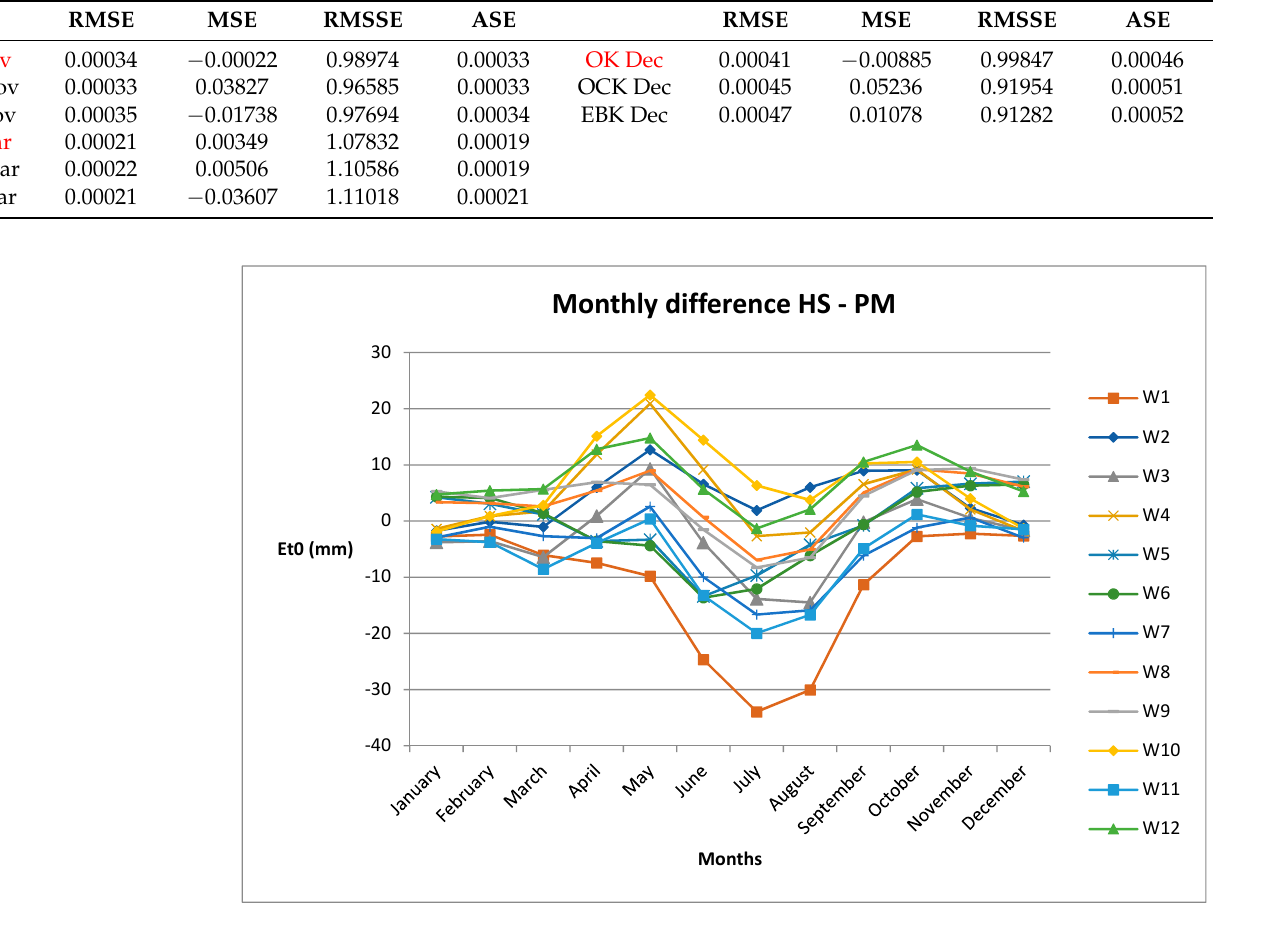
Table 8. Cross validation results for each time interval and for each geostatistical method used; the best method for each interval is highlighted in red.